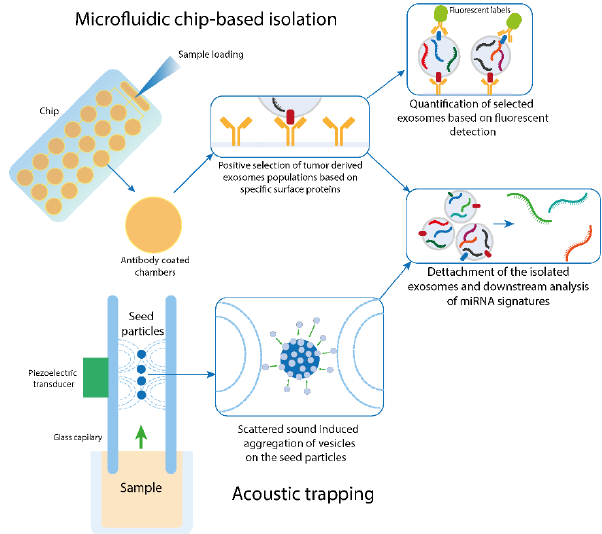
Figure 1. Overview of the principles of microfluidic and acoustic trapping EV isolation